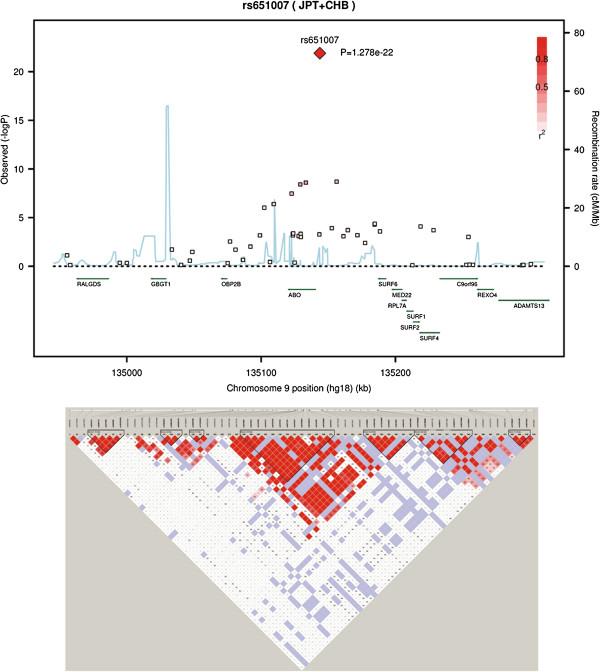
Regional association plot on 9q34 for SNP-ALP associations. The horizontal axis shows the chromosomal positions in the NCBI build 36 genome sequences. In the upper part of the figure, the black dots represent P values of SNPs genotyped by Affymetrix SNP array. The sky blue line shows the recombination rates given by the Hapmap release 22. The middle green arrows indicate the RefSeq genes. The lower part of the figure shows a LD map of r2 values drawn by the Haploview software (http://www.broadinstitute.org/haploview/haploview) using release 22 HapMap genotype data of the Chinese (CHB) and Japanese (JPT).